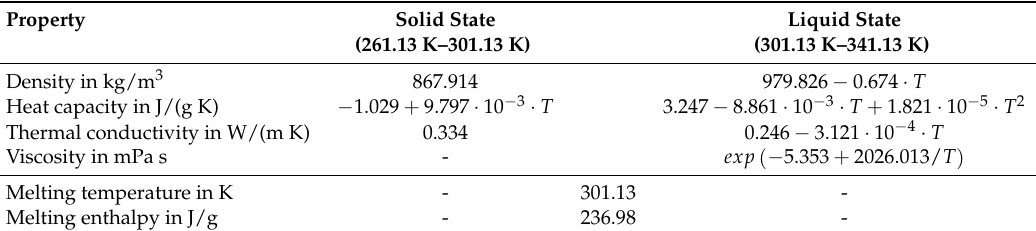
Table 6 summarizes the estimated parameters of the fit functions for the solid and the liquid state. The fit functions are valid from the mean melting point to ± 40 K. Also included in the table are the mean melting point (301.13 K) and the mean melting enthalpy (236.98 J/g). The functions for the indicated confidence intervals are summarized in the Appendix (Equations (A1)–(A18)). Table 6. Estimated fit functions for the temperature-dependent thermophysical properties of octadecane and its mean melting temperature and